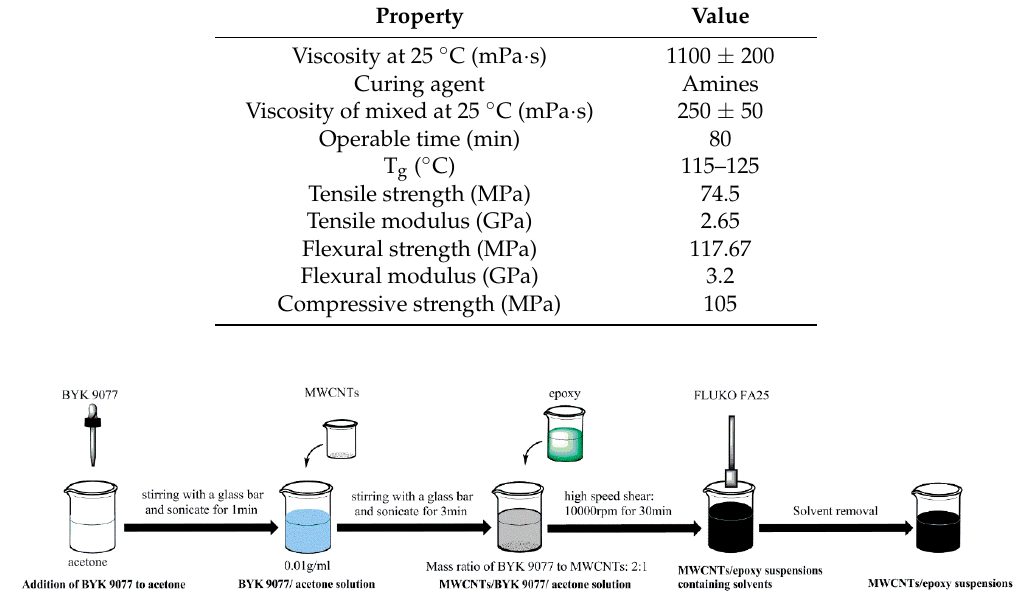
Figure 1. The dispersion process of multi-walled carbon nanotubes (MWCNTs).